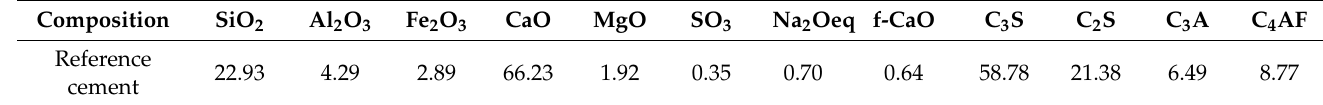
Table 1. Chemical and mineral compositions of reference